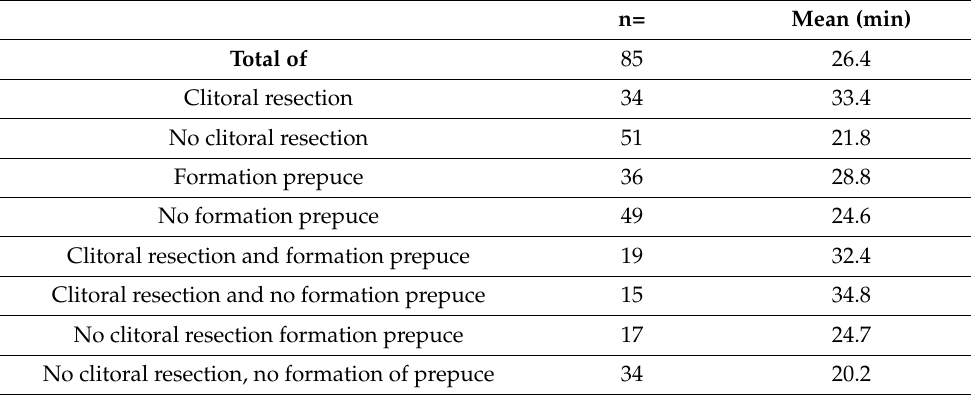
re-elevation of the clitoris without formation of a